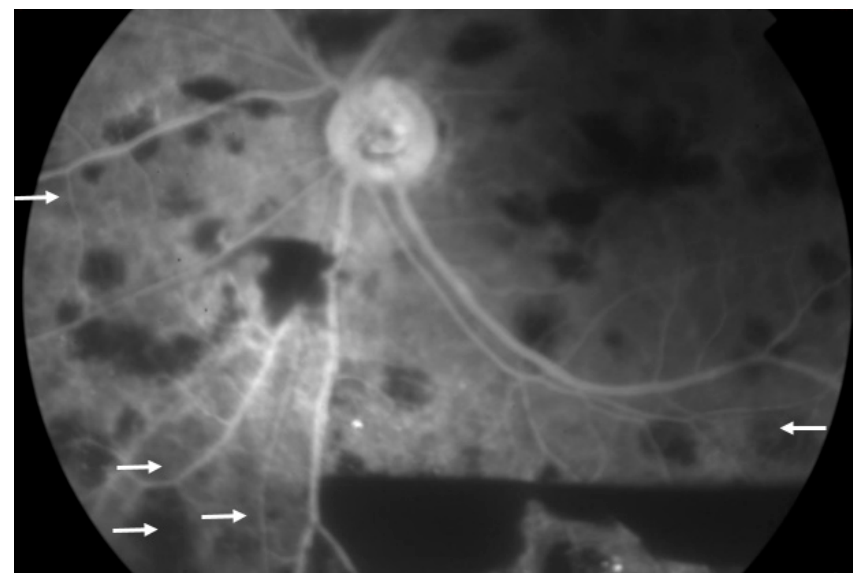
Figure 5. Fluorescein angiography image of the left eye of inferior periphery showing multiple non-perfusion areas (white arrows), indicated retinal ischemia.